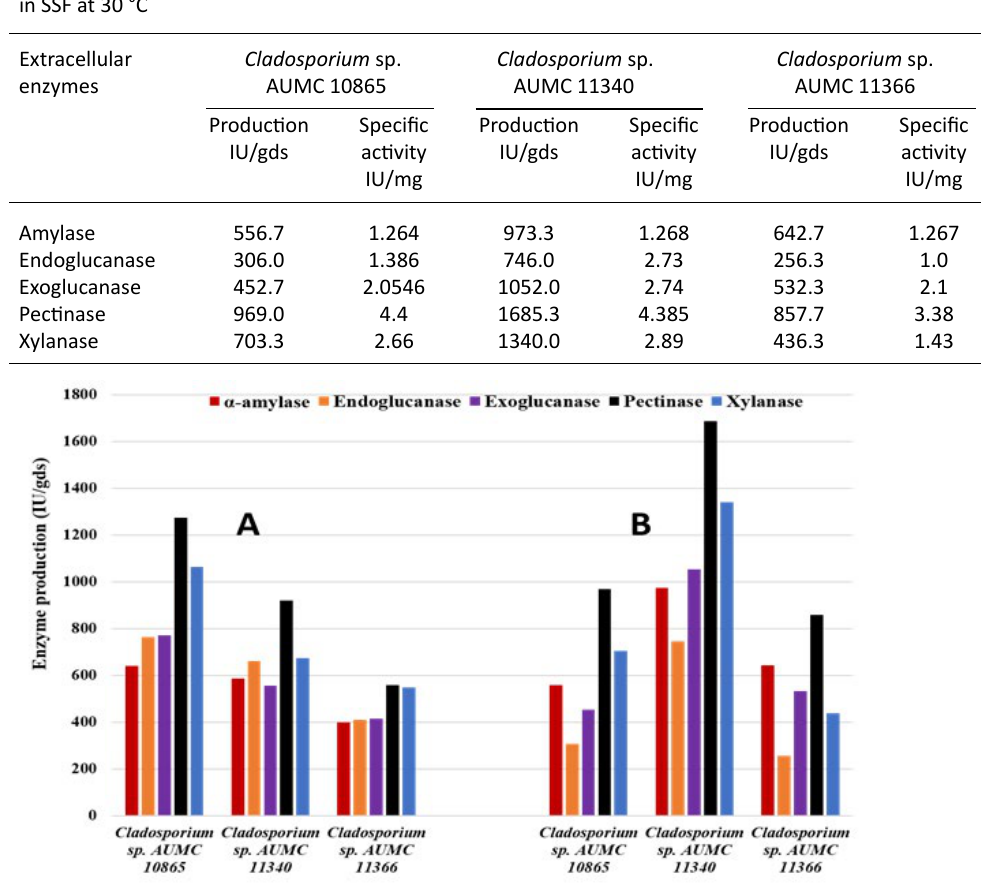
Fig. 4. Enzyme production by Cladosporium isolates AUMC 10865, AUMC 11340 and AUMC 11366 from fresh orange peels in SSF at 10°C (A) and 30°C